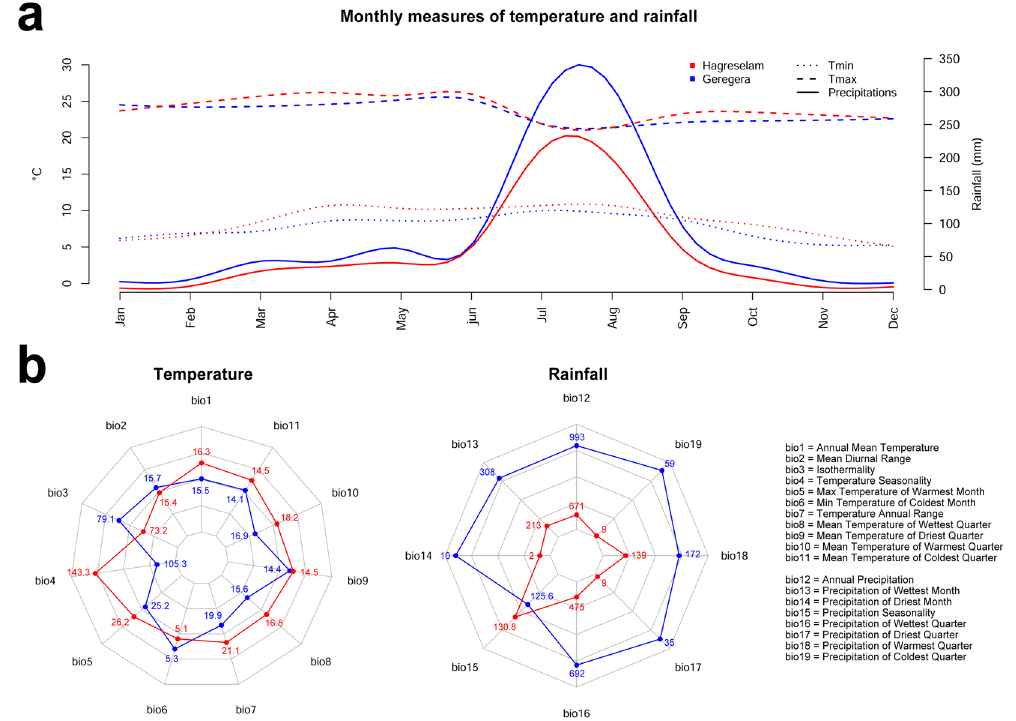
Figure 2. Climatic features of the experimental locations. ( a ) Yearly measures of minimum temperatures, maximum temperatures (y axis on the left side) and rainfall (y axis on the right side) in the two locations. The amount of rain and the duration of the rain season is lower in Hagreselam. Red color for Hagreselam, blue color for Geregera. Line shapes according to legend. ( b ) Bioclim values in the two locations. Among temperature indexes, seasonality separates the two locations the most. Although rainfall seasonality follows the same patterns in the two locations, Geregera is wetter across the year. Colors as in panel